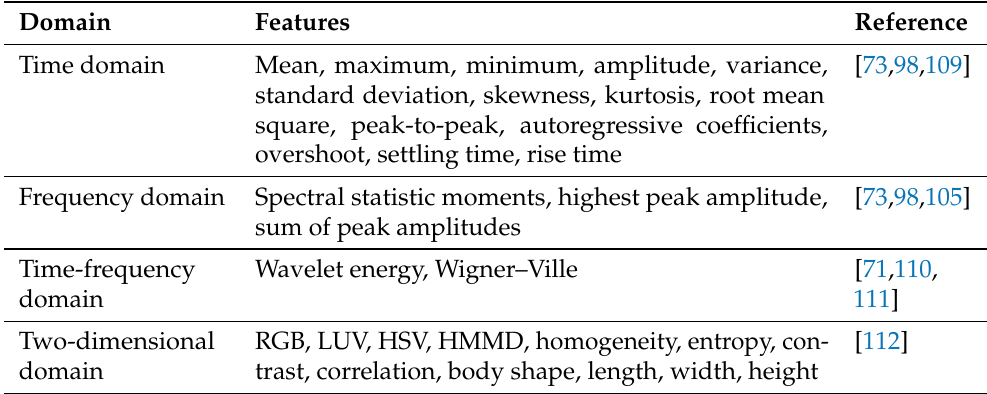
Table 2. Summarised features according to the